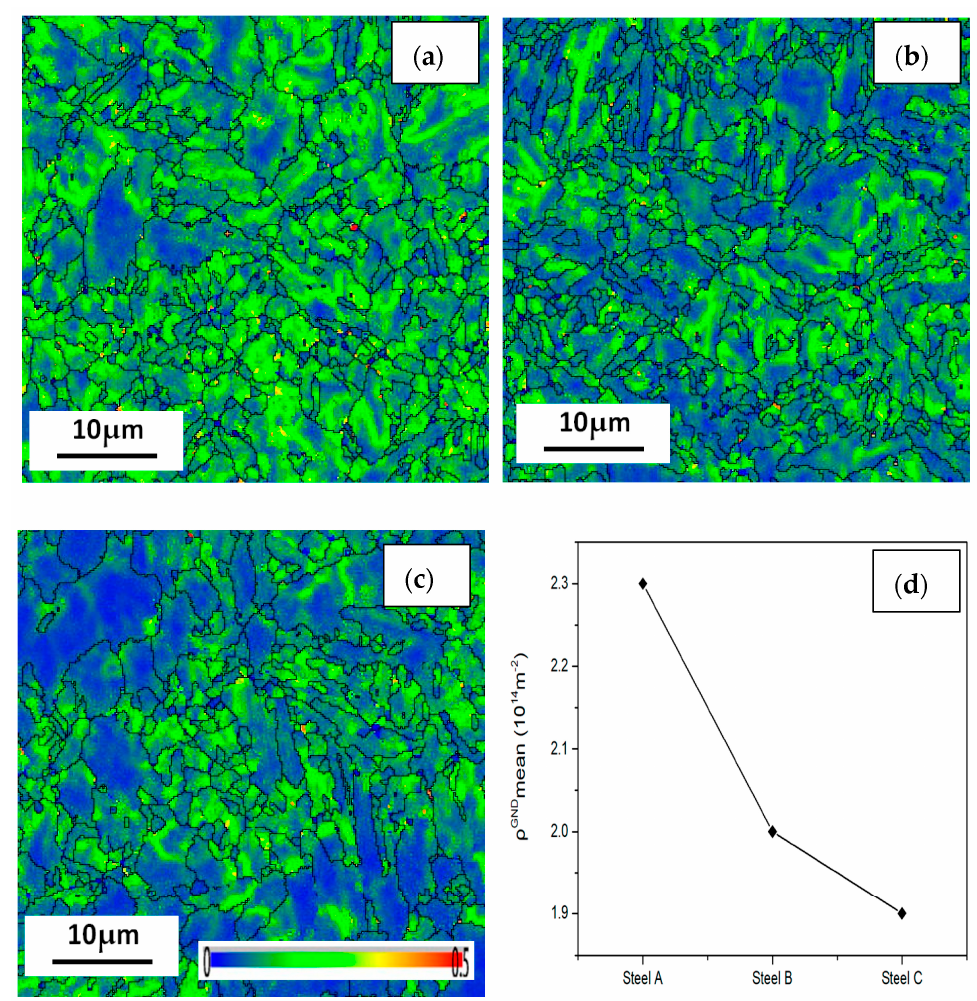
Figure 15. Geometrically necessary dislocations (GND) of the ( a ) steel A, ( b ) steel B and ( c ) steel C specimens; and ( d ) the curve showing their GND number fractions.